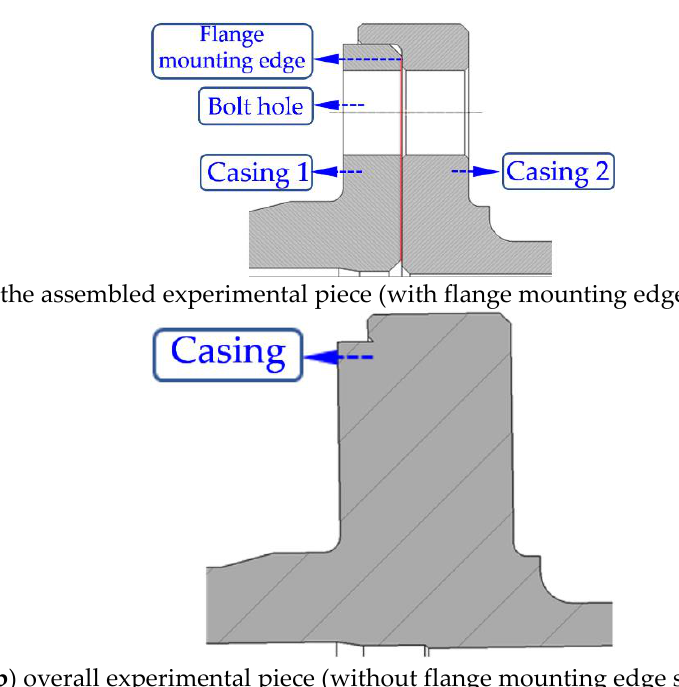
Figure 4. Schematic diagram of the assembled experimental piece and overall experimental piece.